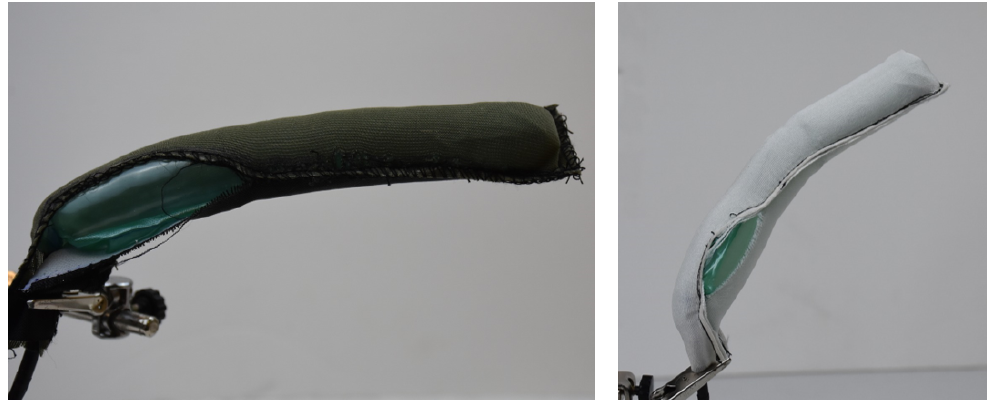
Figure A3. Cut-and-sew actuators bursting upon